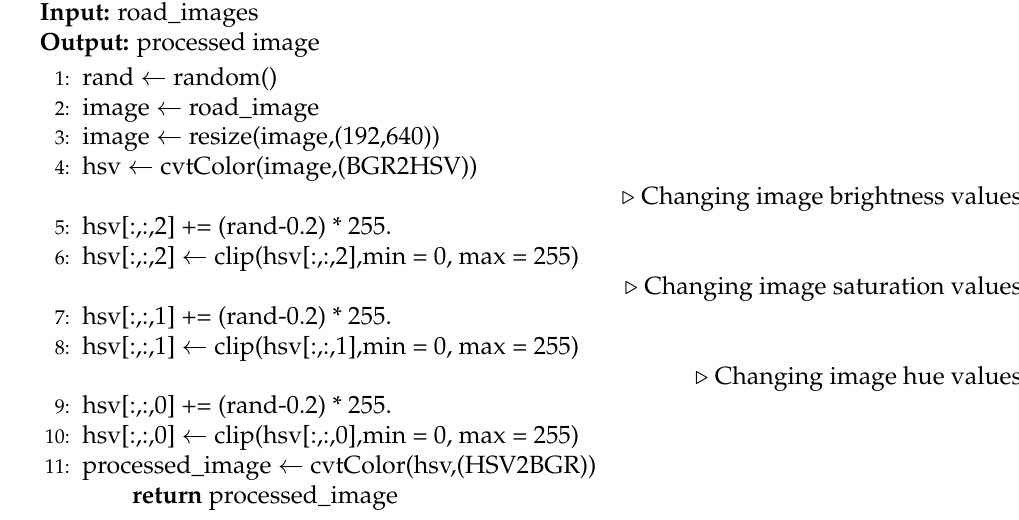
Algorithm 1 Preprocessing the images to make them